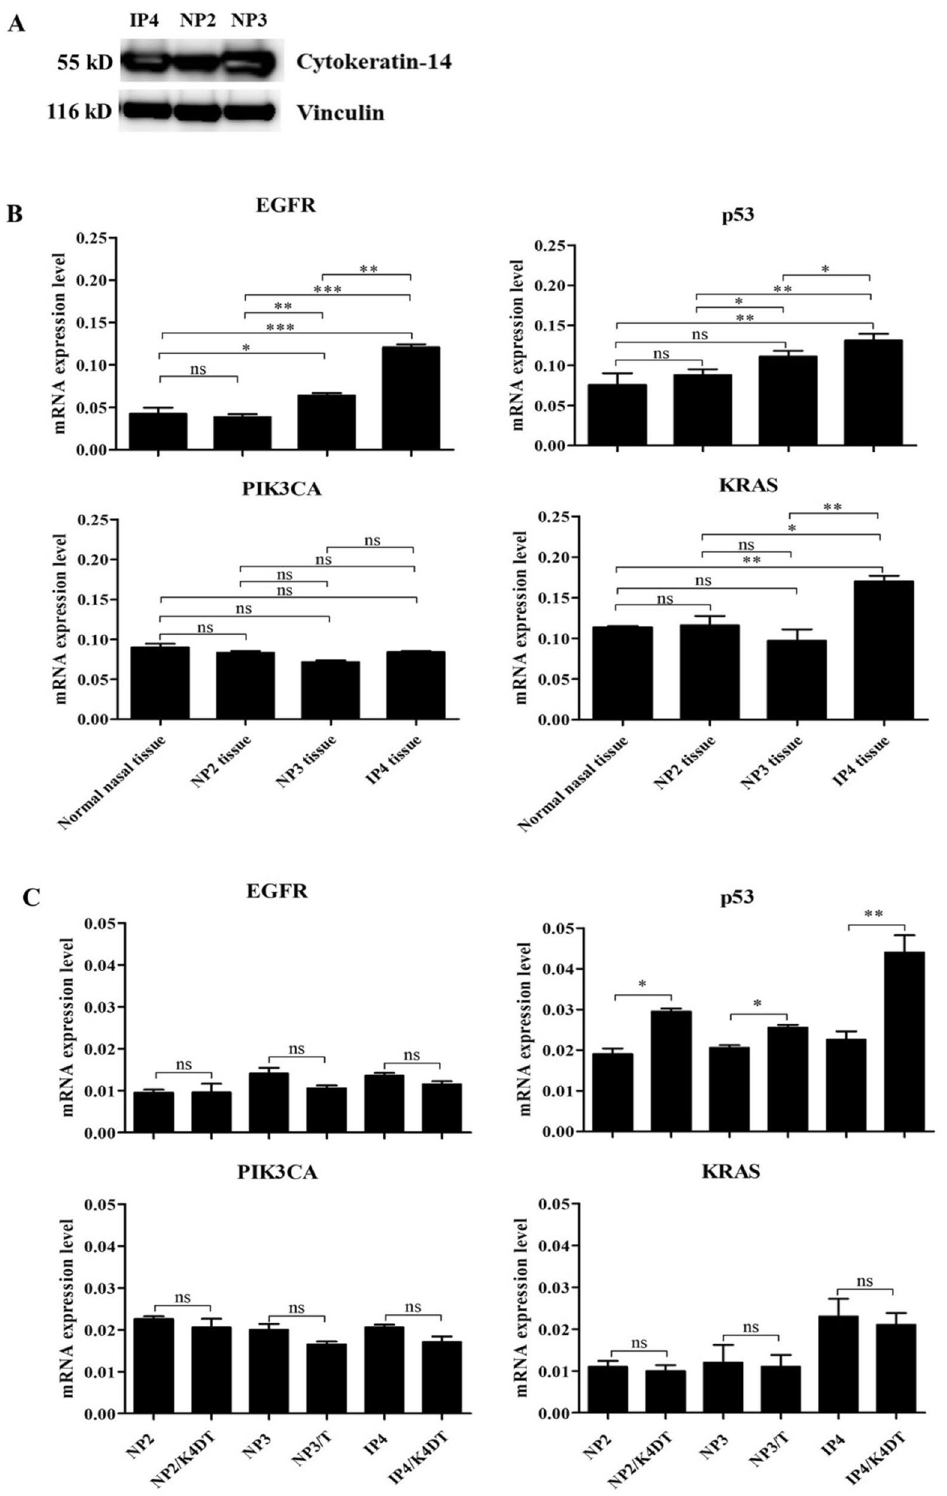
Figure 7. Epithelial origin of established primary cells and the mRNA expression level of EGFR, p53, KRAS, and PIK3CA in primary tumor tissues and established cells. ( A ) Total cell proteins prepared from NP2, NP3, and IP4 cells cultivated in FYAD medium were analyzed for cytokeratin 14 as well as vinculin as a loading control by western blotting. ( B , C ) Total RNA was extracted from primary tumor tissues ( B ) and established cells ( C ) and analyzed for expression of several genes by RT-qPCR as described in Methods. Note that established cells showed a similar expression pattern of target genes to their primary tumors. Asterisks indicate statistically significant difference (* p < 0.05; ** p < 0.01; *** p < 0.001), and “ns” indicates not